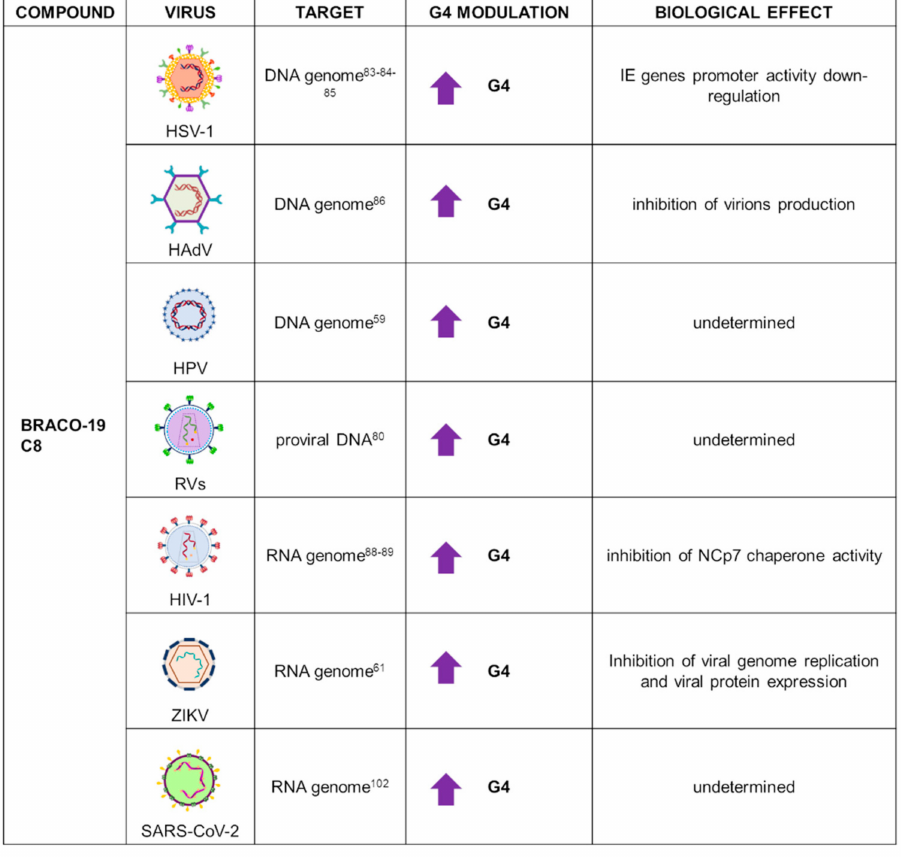
Figure 6. Summary of BRACO-19 applications as a G4 ligand in virology. For each target virus, the site of action (also known as the G4 location), the modulatory effect on G4s, and the overall biological outcome are